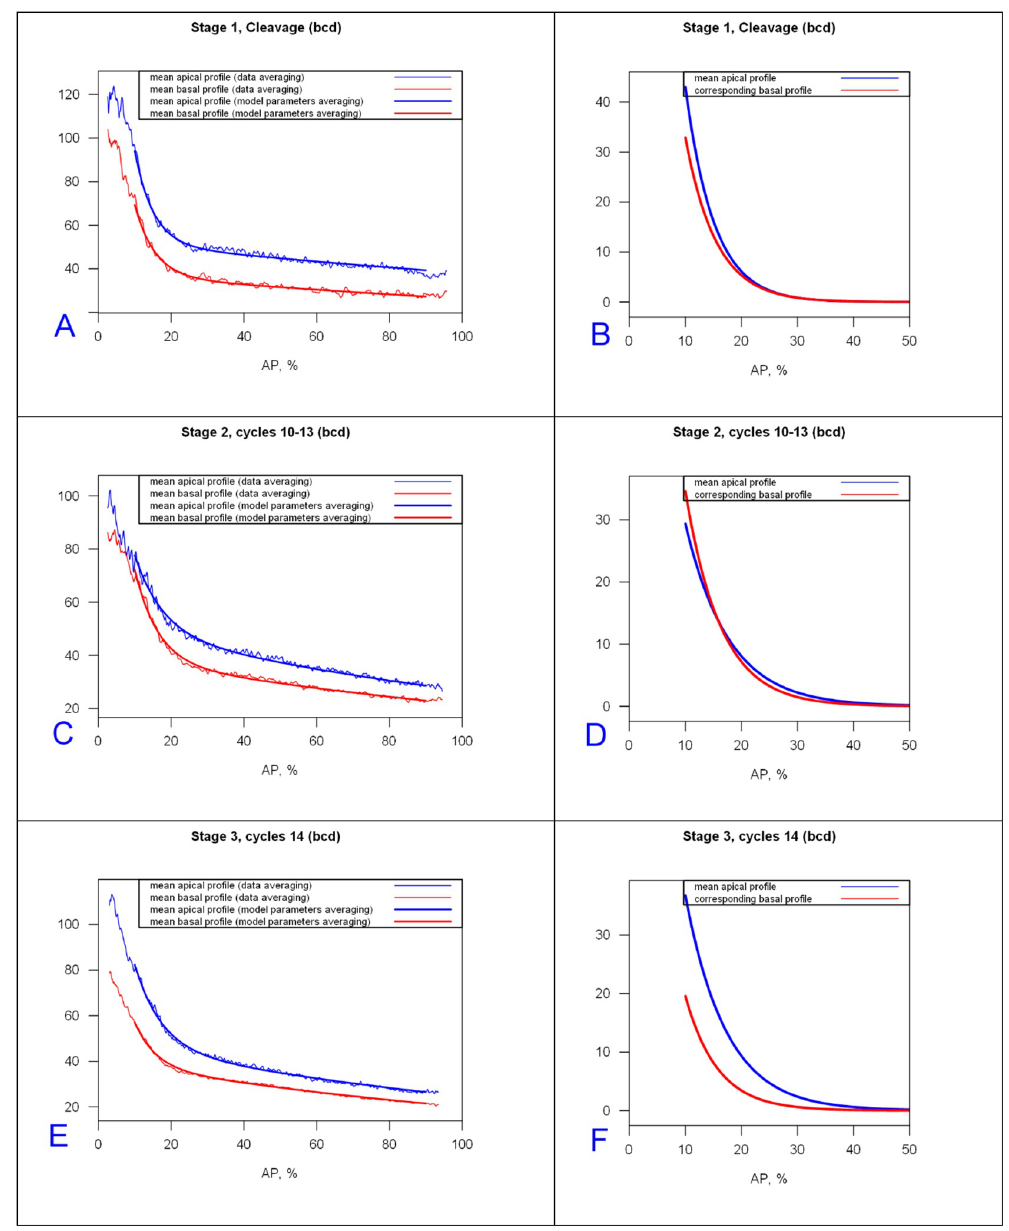
Fig 5. bcd mRNA prototypical profiles and prototypical anterior exponentials for cleavage, cc10-13, and cc14 stages (fit to (10,90) %EL). (A,C,E) profiles from mean parameters of the 2-exponential model overlaid on averaged data. Blue, apical; red, basal. (B,D,F) Anterior gradients only for the mean model profiles from (A,C,E). The anterior gradient approaches zero around 25–30%EL in B; around 30–35%EL in D and the apical profile of F; but around 20–25%EL for the basal profile in